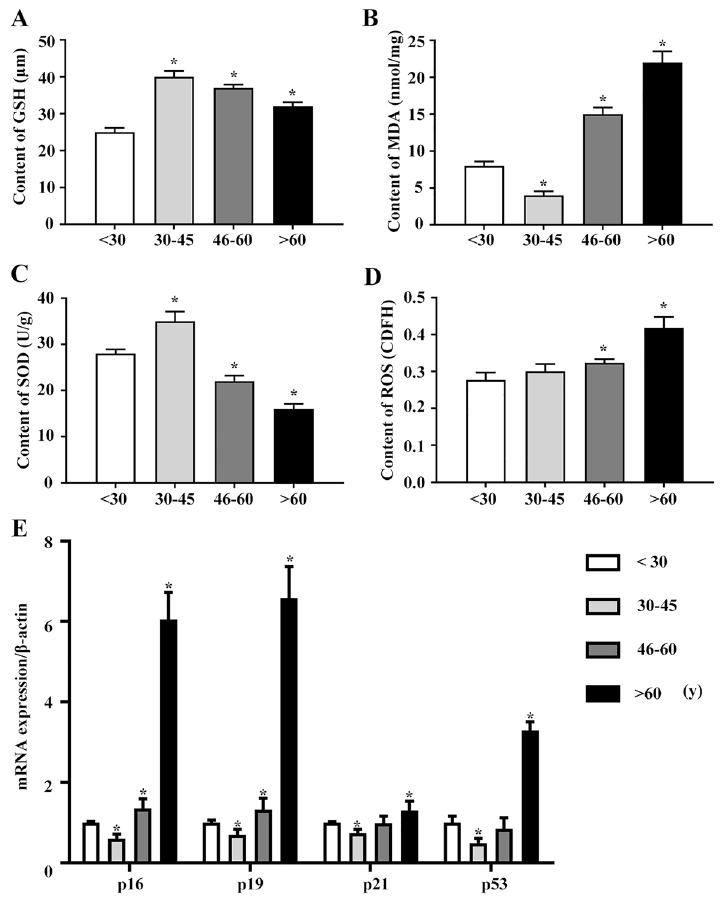
Figure 4. Oxidation/antioxidant system and mRNA expression of p53 and p21 Cip1/Waf1 in hBMHCs obtained from the individuals of different age groups. ( A ) Graphical representation of the GSH content in each sample group. ( B ) Graphical representation of the MDA content in each sample group. ( C ) Graphical representation of the SOD activity in each sample group. ( D ) Graphical representation of the ROS level in each sample group. * p < 0.05: when compared with the < 30 years group. ( E ) mRNA expression of p16, p19, p21, and p53 in hBMHCs obtained from different age groups. * p < 0.05: when compared with the < 30 years